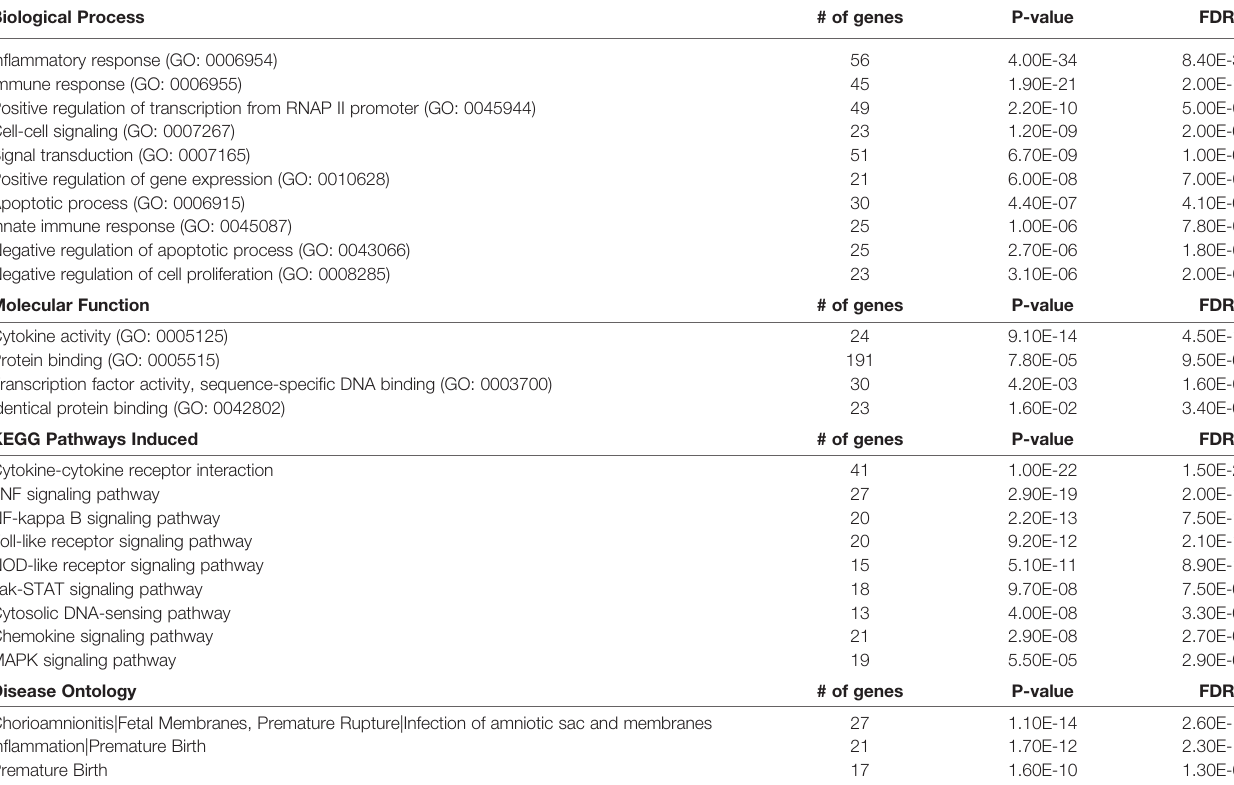
TABLE 3 | Gene Enrichment and